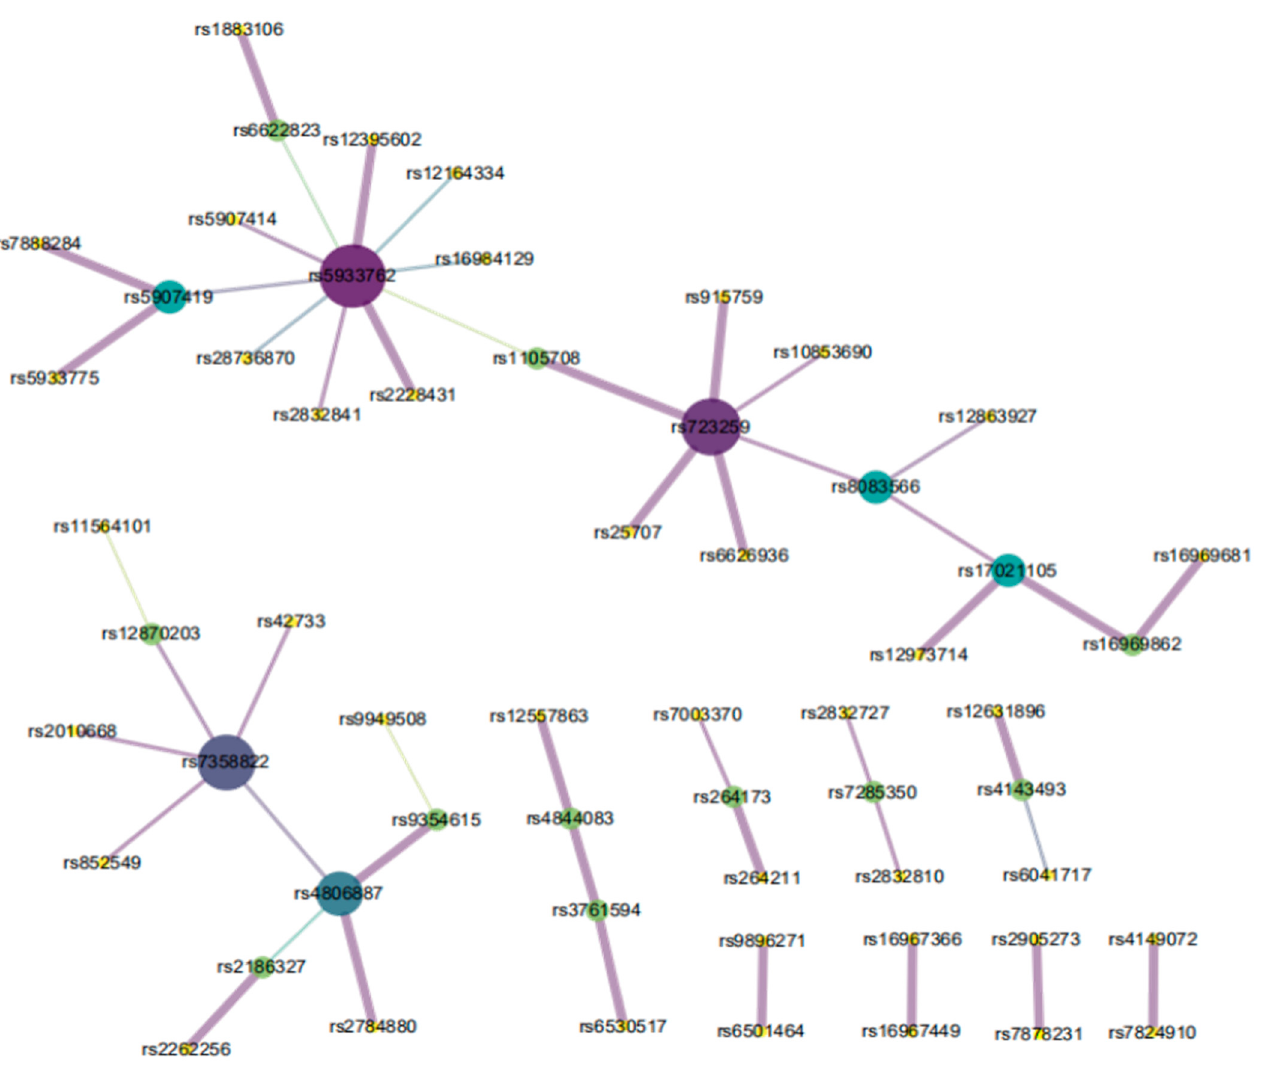
Figure 5. SNP-SNP network of AD.